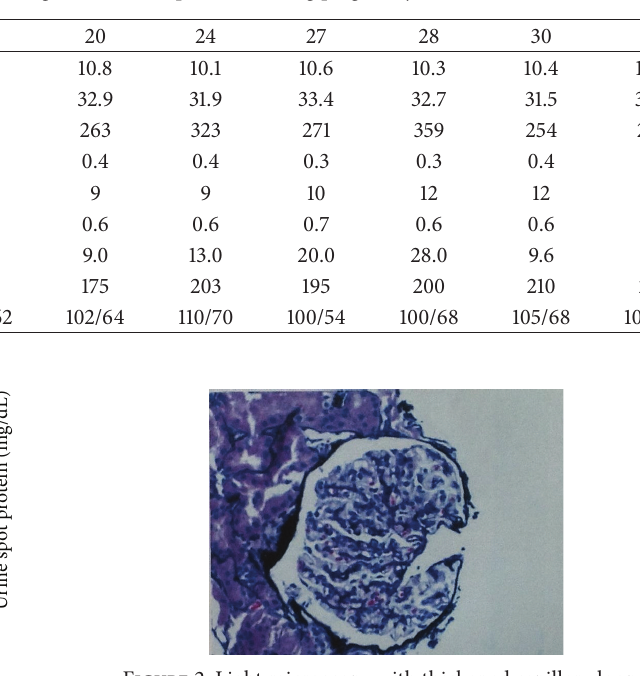
Figure 2: Light microscopy with thickened capillary loops. protein collection, and blood pressure and for fetal